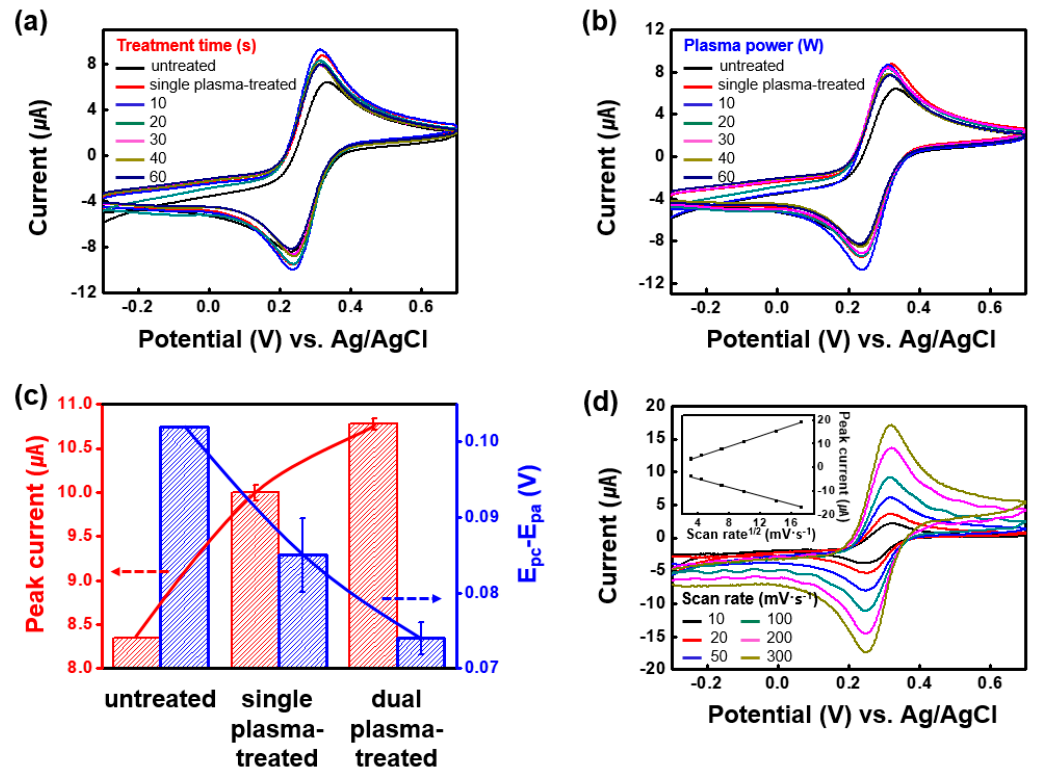
Figure 2. CV diagrams of ( a ) DPT-SWCNT electrodes prepared at various plasma treatment time (plasma power = 10 W) and ( b ) DPT-SWCNT electrodes prepared at various plasma treatment power (plasma treatment time = 10 s) in a 0.1-M KCl solution containing 10-mM Fe(CN) 63 − / Fe(CN) 64 − . Changes in the peak current and the peak potential separation of the untreated, SPT processed and DPT processed SWCNT electrodes are shown in ( c ); CV diagrams and Randles plot of the DPT-SWCNT electrode in the same electrolyte are shown in ( d ). Note that the CV curves of untreated SWCNT SPT-SWCNT are shown together in ( a ) and ( b ) for comparison.